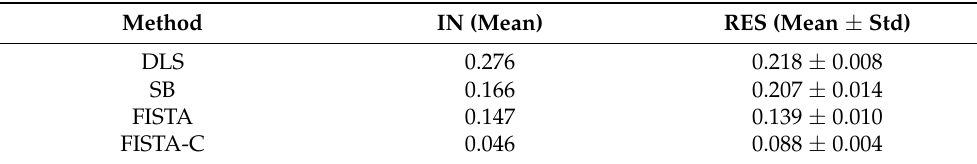
Table 3. Image noise and resolution analysis for imaging results of the four algorithms under various noise levels.